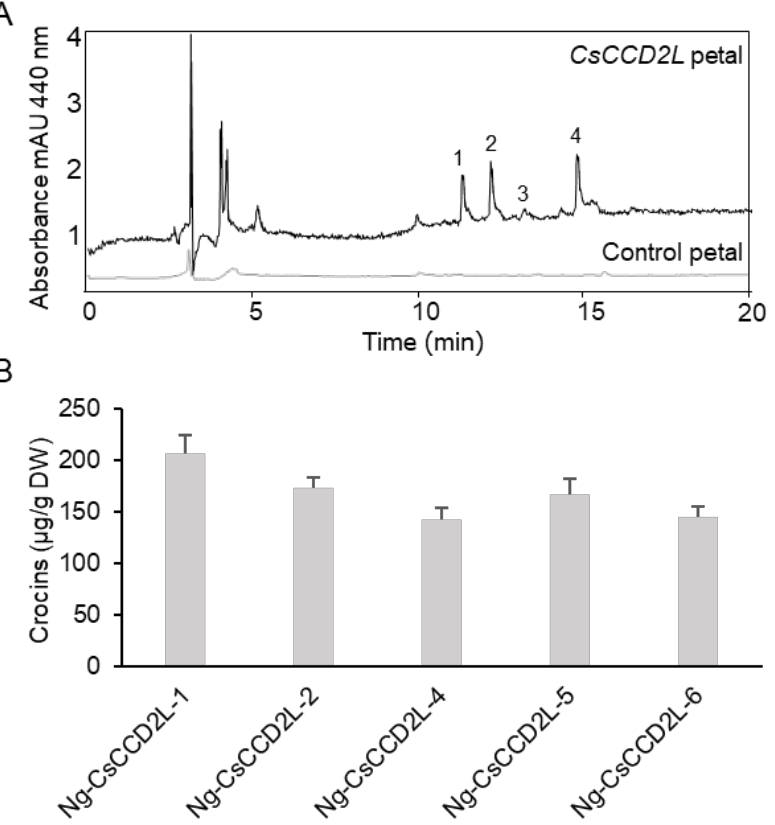
Figure 3. Accumulation of apocarotenoids in Wt and transgenic T1 lines of Nicotiana glauca expressing CsCCD2L . ( A ) HPLC-DAD analysis of polar extracts from Wt N. glauca petals at 440 nm. The peaks for the abundant crocins in the transgenic lines are as follows: 1 = trans-crocin 4; 2 = trans-crocin 3; 3 = trans-crocin 2; 4 = cis-crocin 2; crocins were completely absent from Wt plants. mAU, milli-absorbance units. ( B ) Apocarotenoid accumulation in the petals of transgenic lines. Analyses were conducted in triplicate. Error bars represent the SD. DW, dry weight.